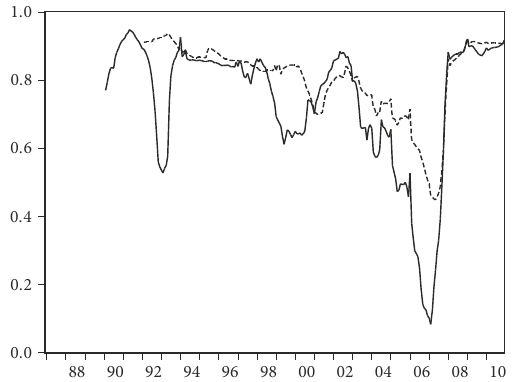
Figure 3. Autoregressive parameters estimated using a Kalman filter on the basis of 36 and 60 Table 2. Additions to/deductions from the base value in Chaplin’s method k i Market states Return hypothesis Additions/Deductions